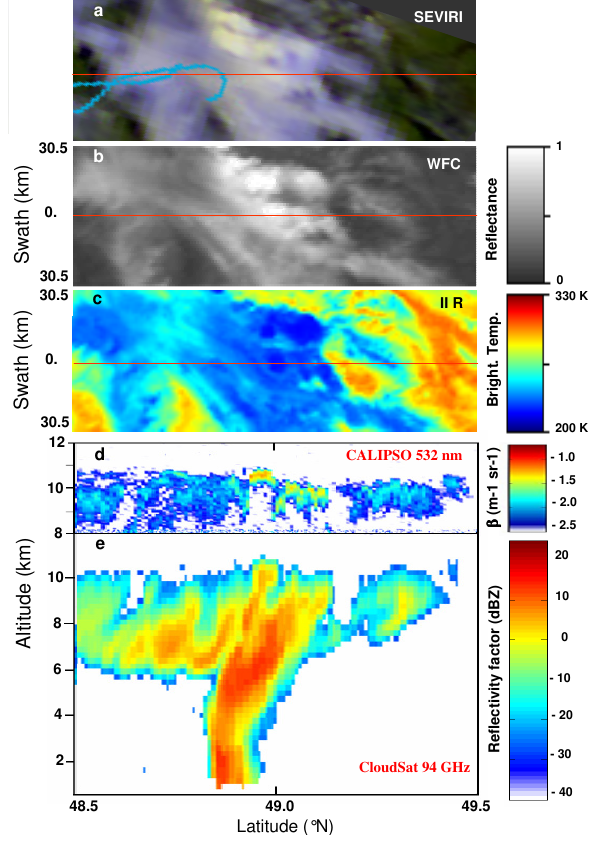
Fig. 4. Composite-latitude representations (between 48.5 and 49.5 ◦ N, i.e. area study) of: (a) SEVIRI (color composite); (b) Wide Field Camera (WFC) images; (c) Imaging Infrared Radiome- ter (IIR); (d) Vertical profile of the attenuated backscatter coefficient from CALIOP and (e) vertical profile of the equivalent reflectiv- ity factor from CloudSat. CALIPSO (WCF, IIR and CALIOP) and CloudSat observations were taken at 12:32UT. The Falcon trajec- tory (from 12:15 to 12:45) is superimposed on the SEVIRI image (taken at 12:30UT). The CALIPSO trace (red line) is reported on SEVIRI, WFC and IIR